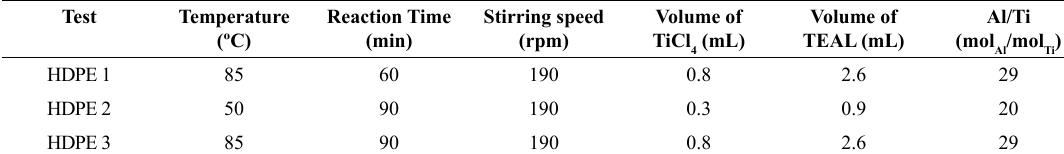
Table 1. Experimental conditions used in the polymers production